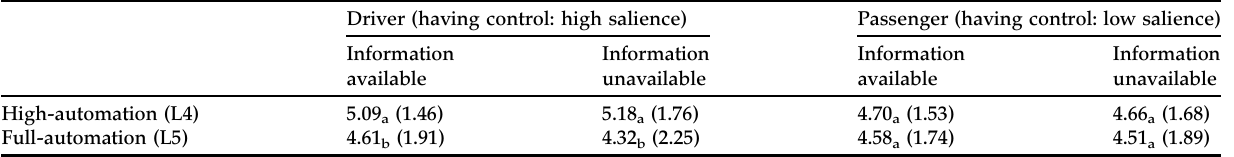
Table 1. Cell means of perceived safety in study 3. Driver (having control: high salience) Passenger (having control: low salience)